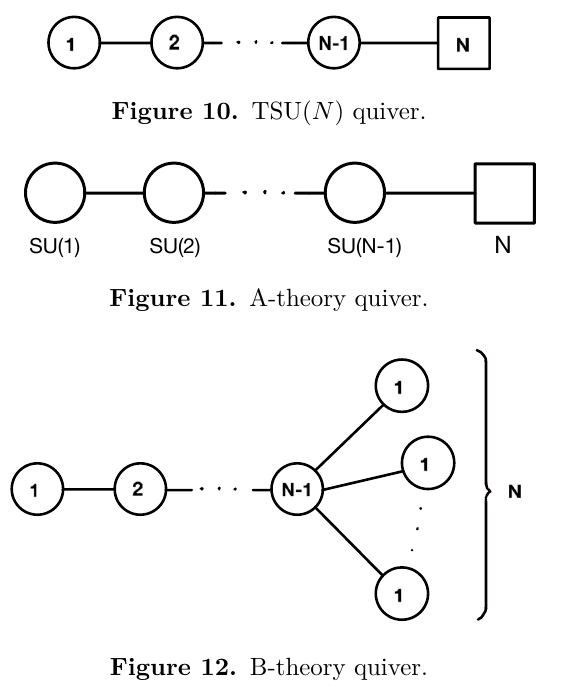
Figure 10. TSU( N ) quiver.